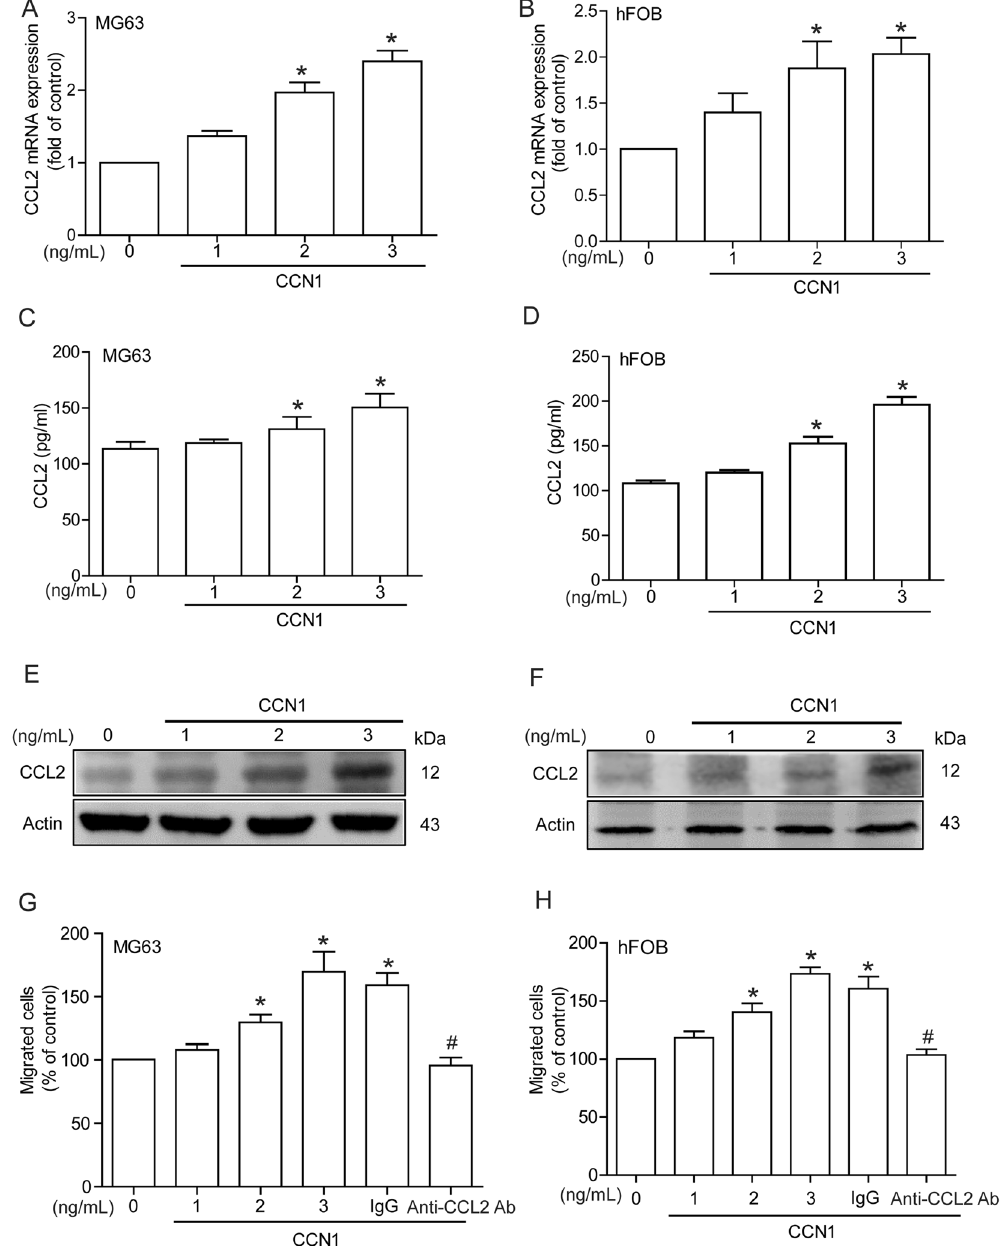
Figure 2. CCN1 promotes CCL2-dependent monocyte migration. ( A – F ) MG63 and hFOB cells were incubated with various concentrations of CCN1 (0–3 ng/ml) for 24 h; CCL2 expression was examined by qPCR, ELISA, and Western blot analysis (n = 5 per group). ( G and H ) Osteoblasts were incubated with CCN1 (0–3 ng/ml) for 24 h, or pretreated for 30 min with IgG control antibody or CCL2 antibody, followed by stimulation with CCN1 (3 ng/ml) for 24 h. Medium was collected as CM and THP-1 migration was assessed by in vitro chemotaxis assay (n = 5 per group). Results are expressed as the mean ± S.E. * p < 0.05 compared with